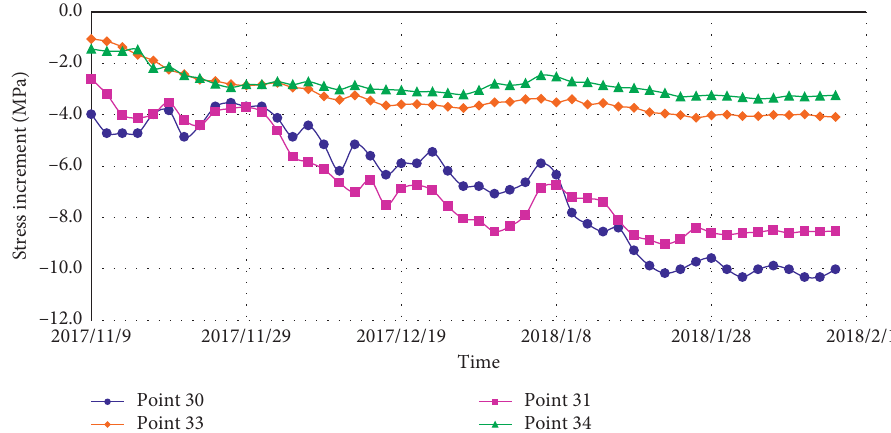
Figure 19: Stress increment in the z direction of each measuring point during the process of bearing capacity recovery. Table 2: Measured and calculated values of an increment in the stress of column 5 during the process of bearing capacity recovery. Measuring